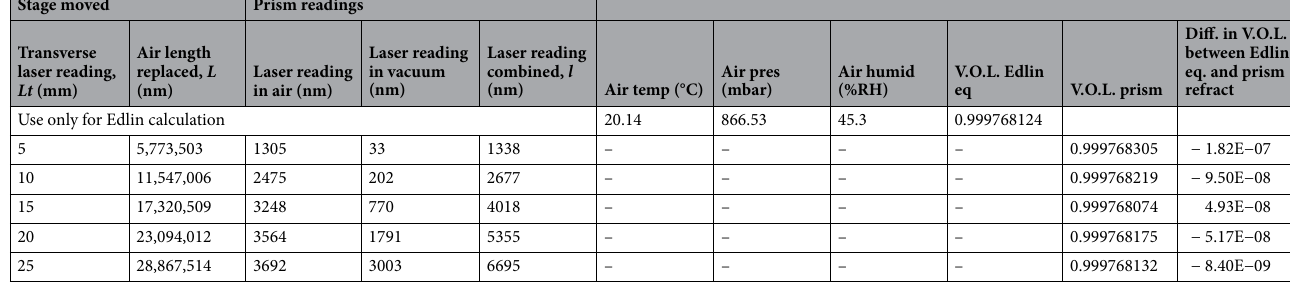
Table 1. Results for the prism refractometer data compared to the modified Edlin equation using weather station measurement